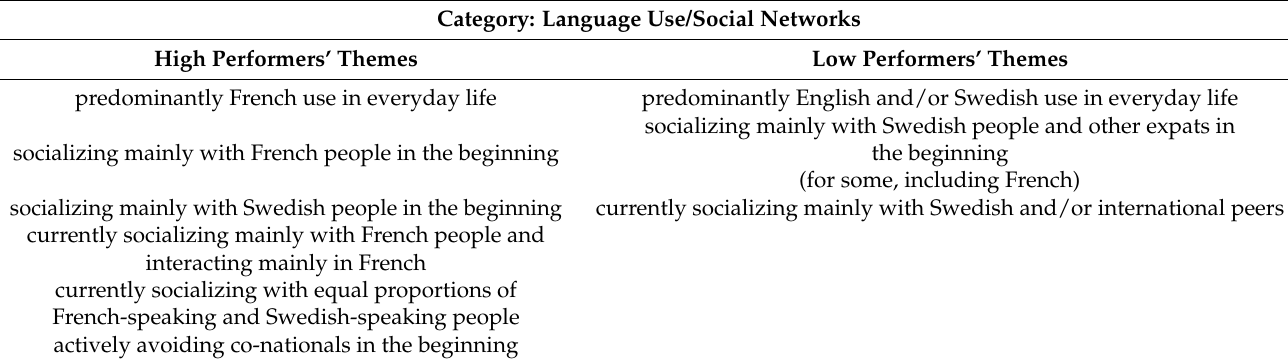
Table 3. Identified themes in the category “Language use/Social